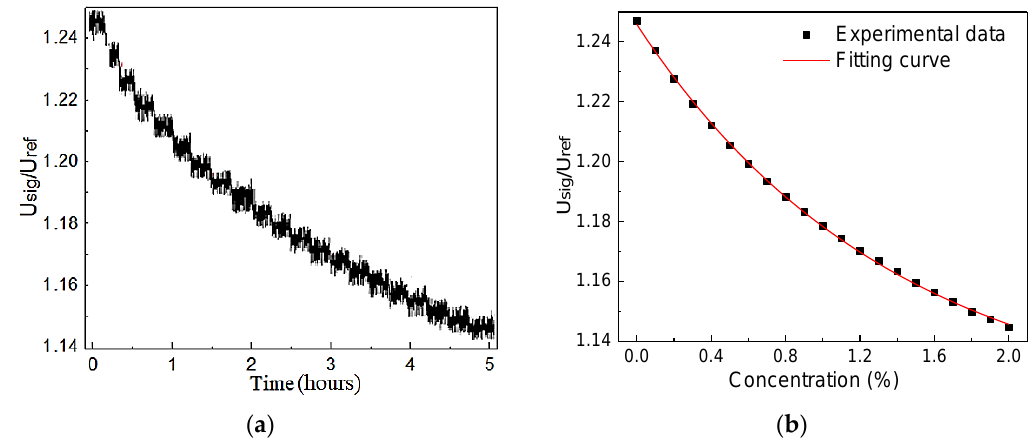
Figure 10. ( a ) The measured voltage ratio between the two channels from the detector versus calibration time t for 20 CH 4 concentration levels. ( b ) Experimental data and fitting curve.